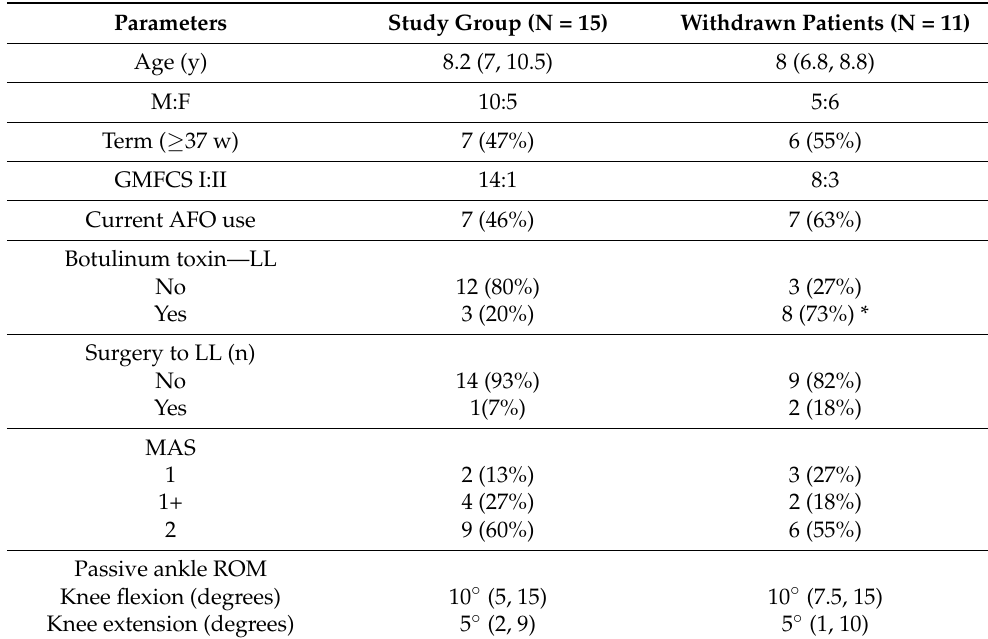
Table 1. Clinical and demographic parameters of the study group and patients who